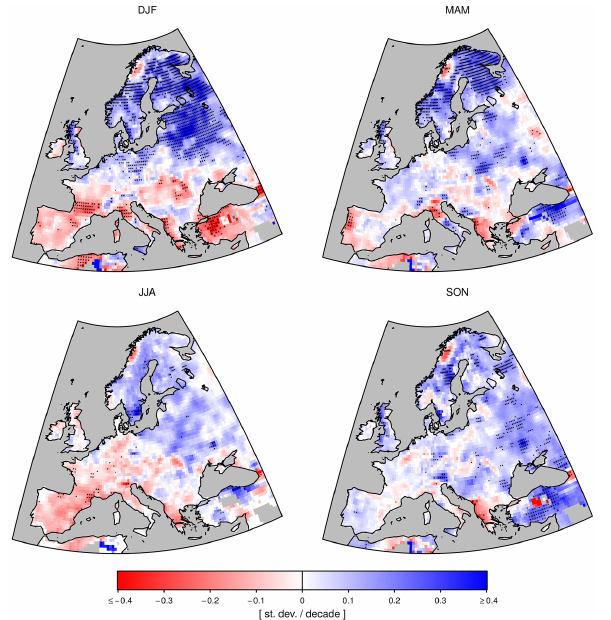
Figure 2. Seasonal patterns in SPI-3 trends. Trend patterns are evaluated for four months, of which the accumulation time cov- ers the respective season. For winter (DJF), SPI-3 is evaluated for the month of February, which accounts for accumulated precipita- tion in the three winter months (Dcember, January, February). For spring (MAM), SPI-3 is evaluated for the month May, accounting for accumulated precipitation in March, April and May. For sum- mer (JJA), SPI-3 is evaluated for August, accounting for accumu- lated precipitation in June, July and August. For autumn (SON), SPI-3 is evaluated for the month of November, accounting for accu- mulated precipitation in September, October and November. Trends are expressed in units of standard deviations per decade. Stippling indicates local significance ( α local < 0.05). Field significance is re- ported in Fig.